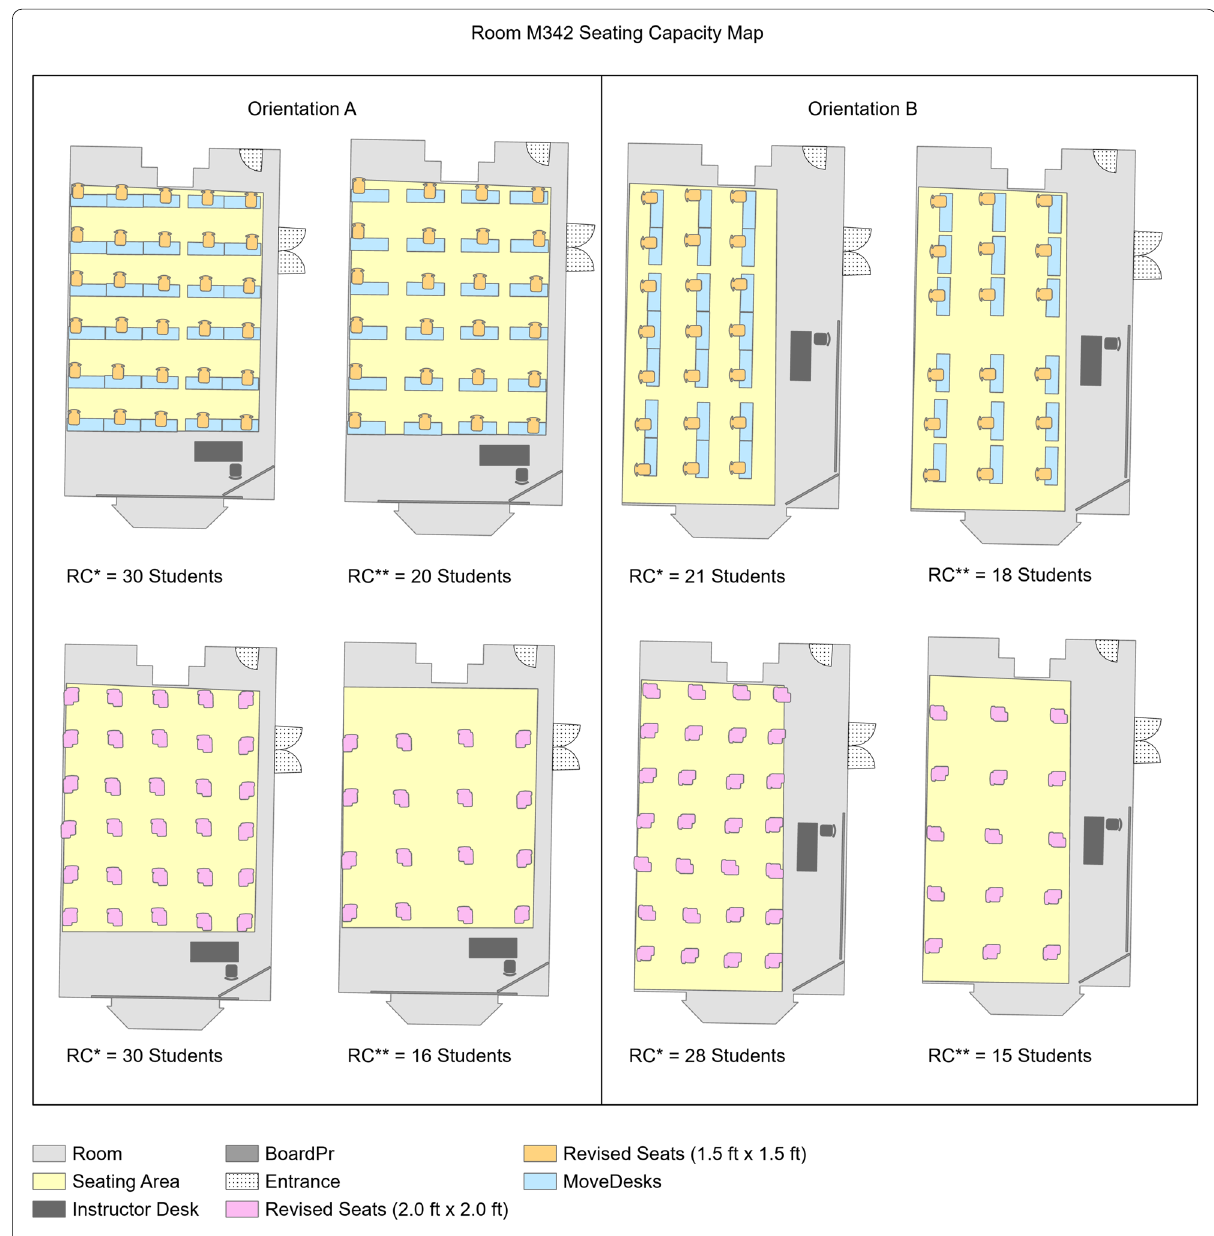
Fig. 5 Revised seating capacity map for room